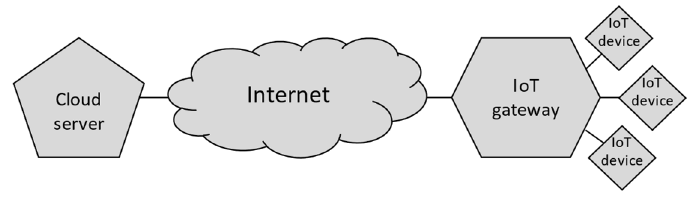
Figure 1. The general architecture of IoT-Crypto network.